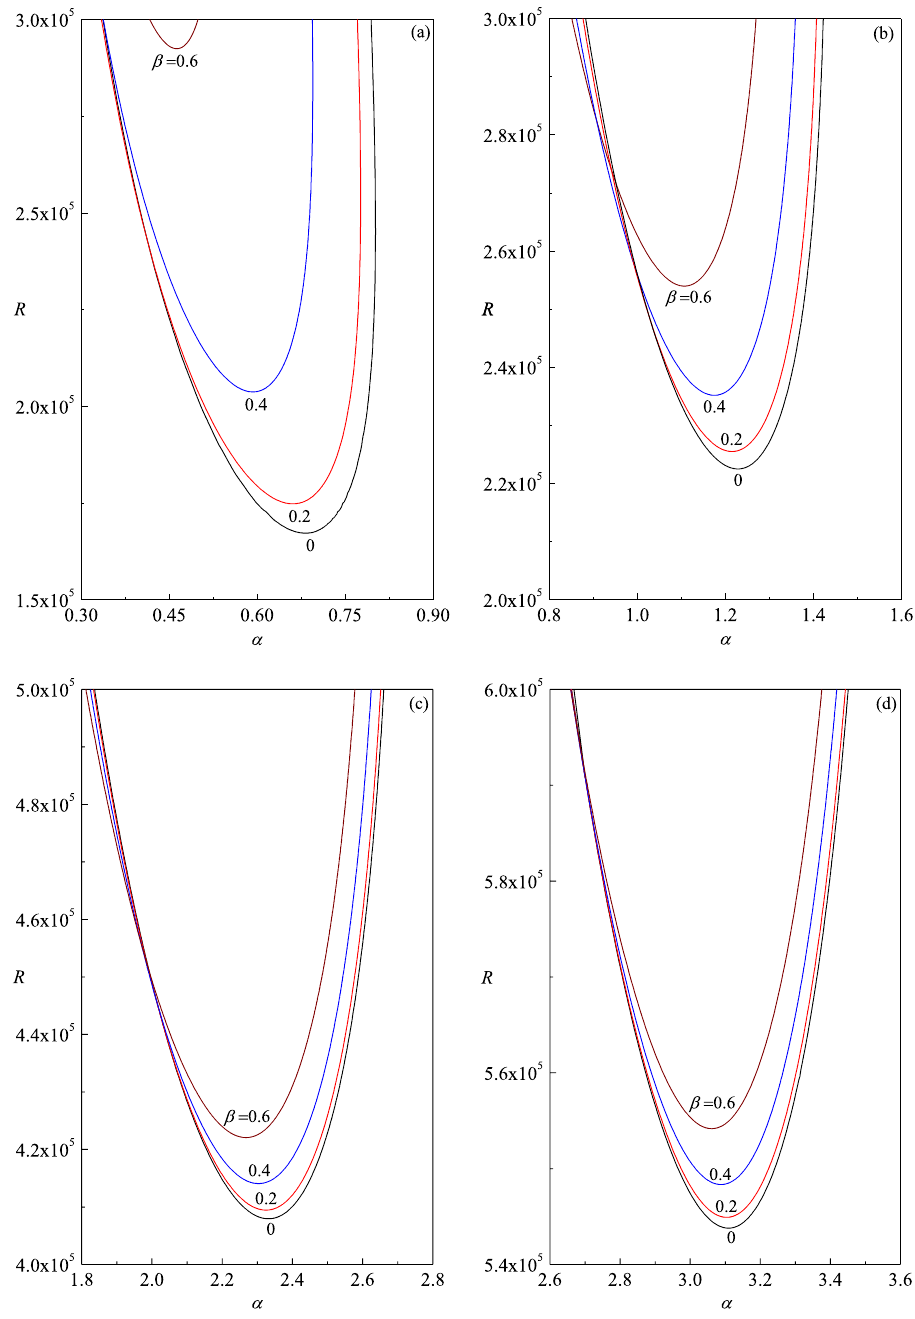
Figure 4. Neutral stability curves in the (α , R ) -plane for different values of β with ( a ) R T = 5 , ( b ) R T = 8 , ( c ) R T = 15 and ( d ) R T = 20